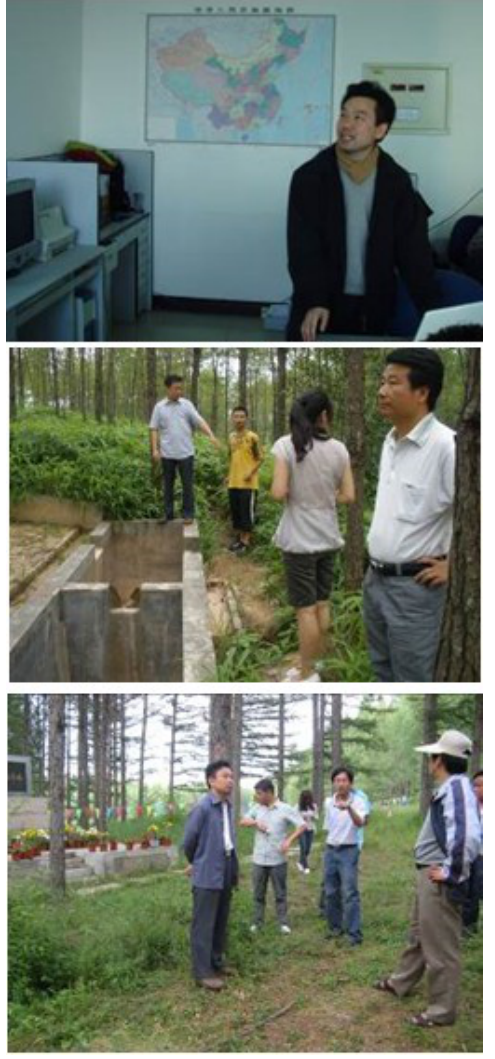
Fig. 3 . Shixiong Cao is a teacher who shares his knowledge in a university environment (Top), a guide who directs the students in scientific research in the field (Middle), and a consultant who shares his experience with local government managers and farmers (Bottom).